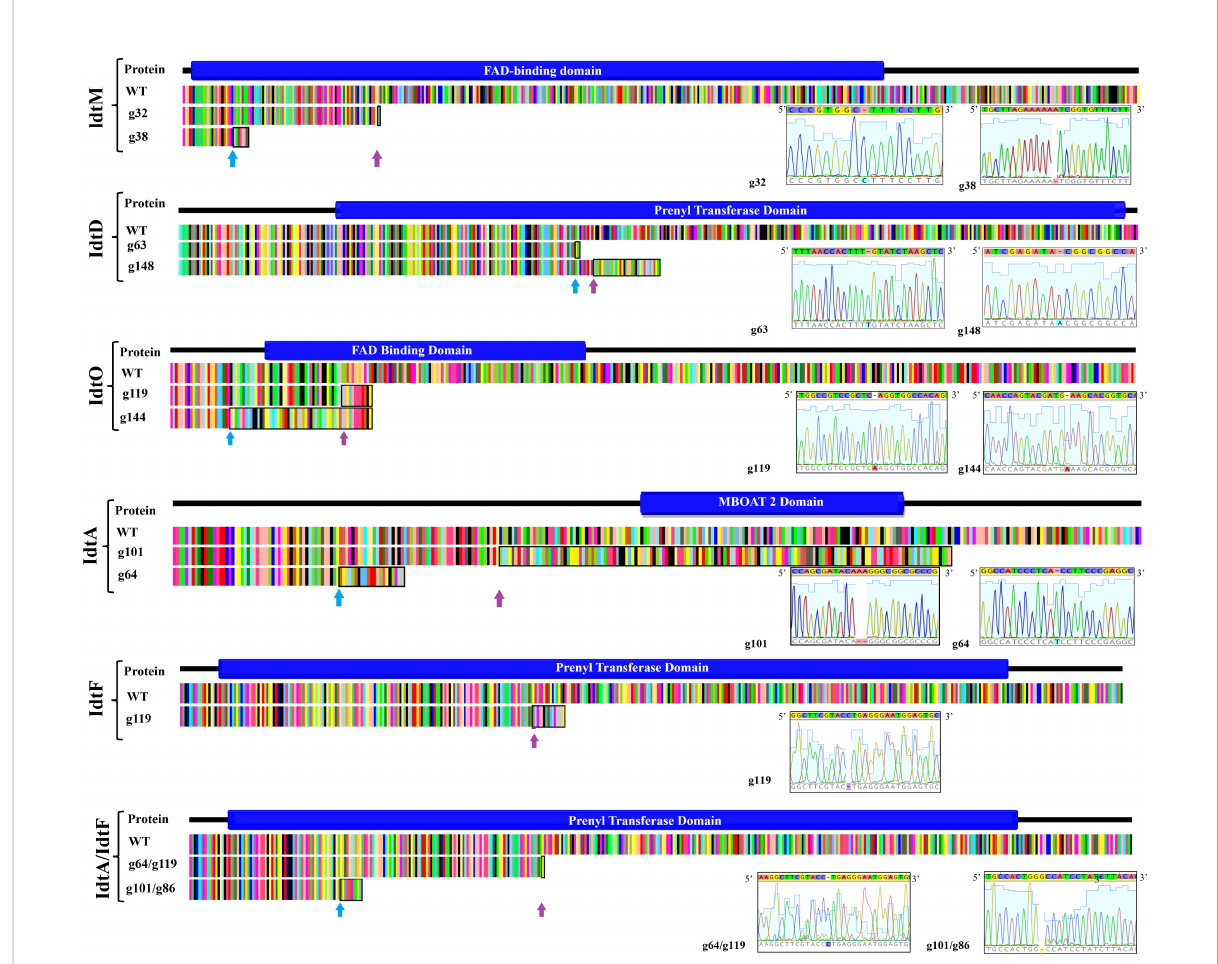
FIGURE 2 Resultant polypeptide and corresponding transcript of CRISPR gene edited indole diterpene genes in the proposed epoxyjanthitrem pathway. Pictorial depiction of the resultant polypeptide and corresponding transcript due to CRISPR gene inactivation of the indole diterpene genes idtM, idtD, idtO, idtA, idtF, and idtA/idtF when compared to the AR37 wild type transcript (WT) and the functional domain. The functional domain was predicted using the online software IntroPro Scan. The amino acid sequence of the AR37 wild type and CRISPR gene edited strains are colour coordinated by amino acid type with the indel site indicated in the CRISPR gene edited strains by a coloured arrow. The black box highlights the non-homologous amino acid sequence resulting from the indel. Description of the gene, guide, transformant number, indel, and frameshift is provided on the left-hand side of the fi gure and/or in the inserted table, with sequencing data provided in inserted